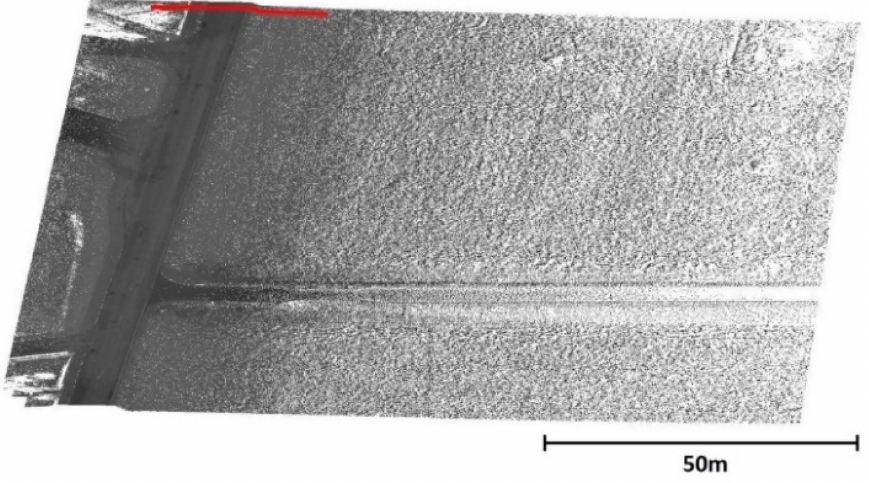
Figure 5. Site 1: data after MDSR filtering; red line indicates locations of profiles presented in Figure 6.